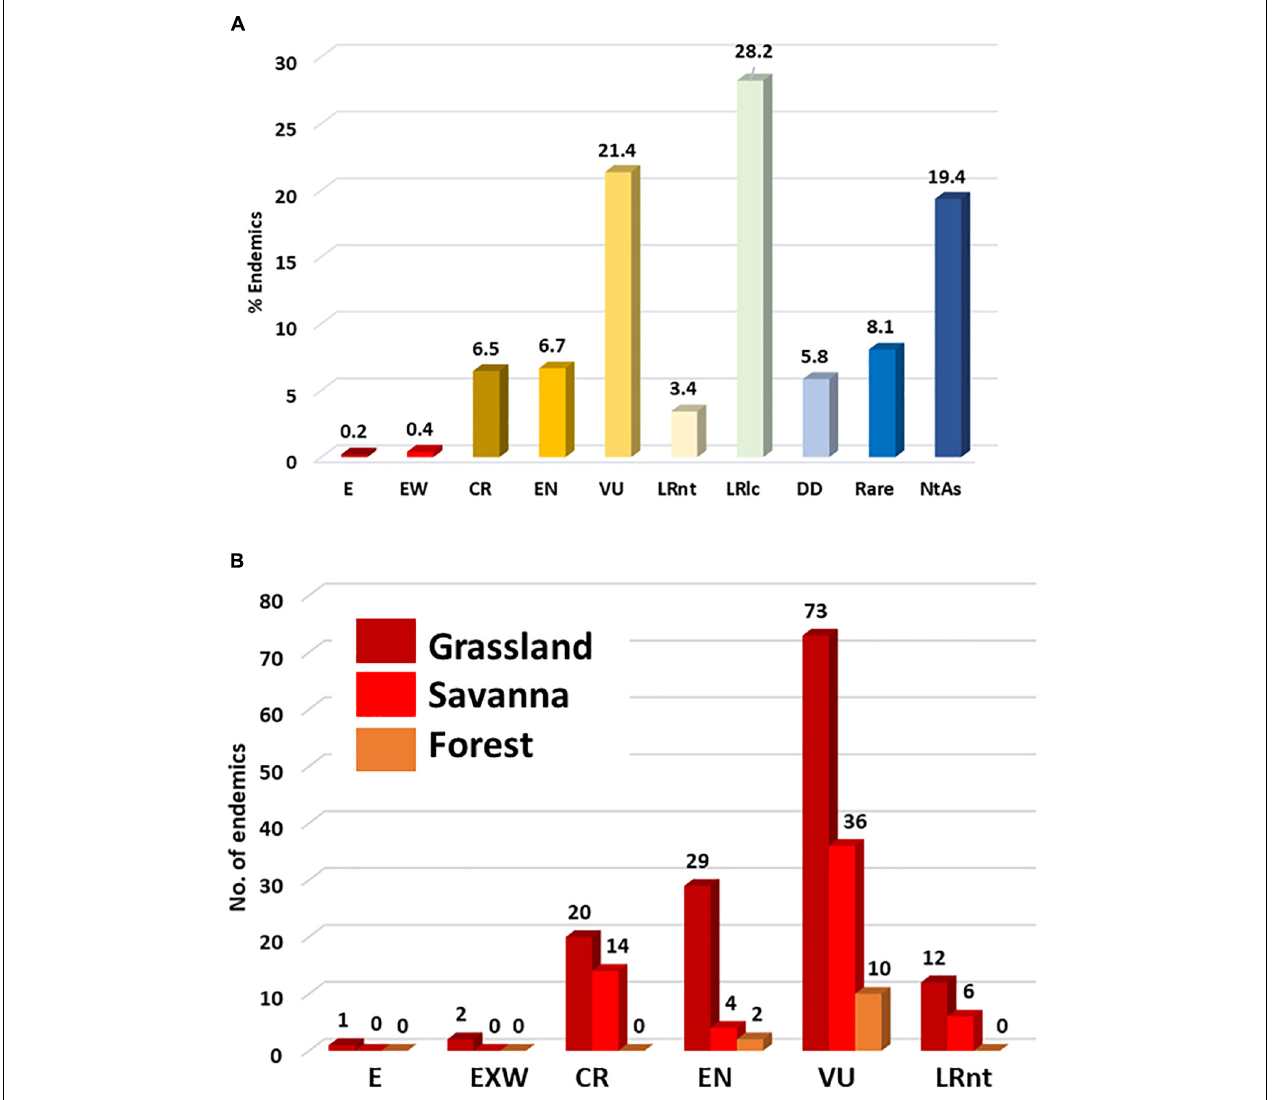
FIGURE 6 | Distribution of endemic plant taxa in the Limpopo–Mpumalanga–Eswatini Escarpment (LMEE) according to (A) IUCN Red Data conservation status, and (B) according to those in the threat bundle (i.e., Lower Risk: Near Threatened to Extinct) per Biome. E, Extinct; EW, Exinct in the Wild; CR, Critically Endangered; VU, Vulnerable; LRnt, Lower Risk: near-threatened; LRlc, Lower Risk: least concern; DD, Data Deficient; NtAs, Not Assessed (Not Evaluated).